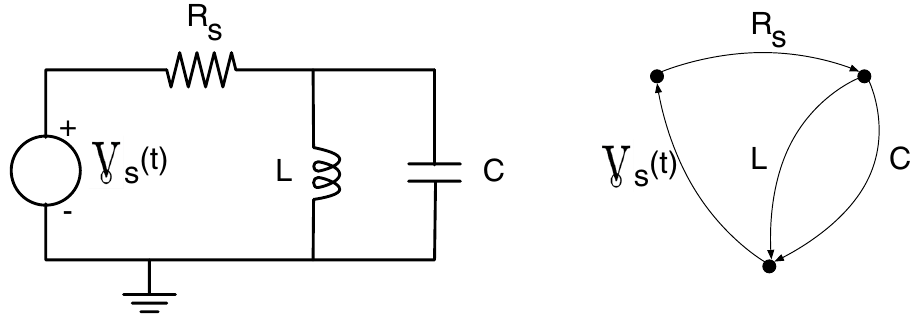
Figure 5. A simple RLC circuit shown as a circuit diagram on left and as a linear graph model on right. Each resistor, capacitor and inductor can be said to be part of its own layer by virtue of their distinct constitutive